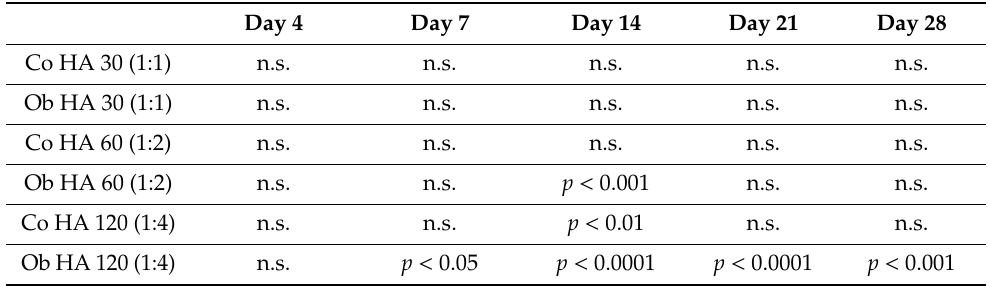
Table 2. Statistical ANOVA analysis of JPC proliferation activities calculated in comparison to cells growing within collagen sca ff olds without HA (groups Co Ø HA and Ob Ø HA from Figure 7). n.s. = not significant; Co = untreated control; Ob = osteogenically induced samples. Day